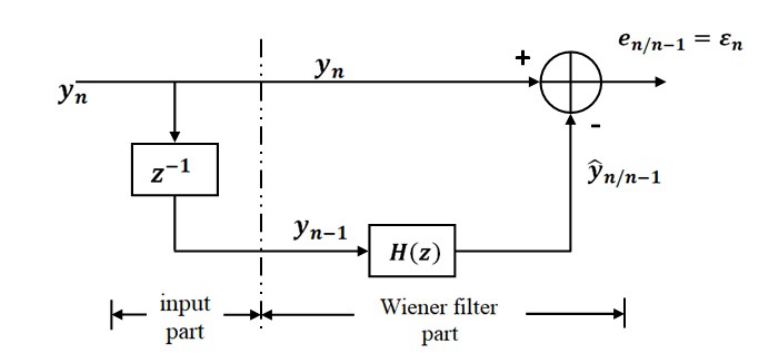
Figure 1: Error Predictor through Wiener